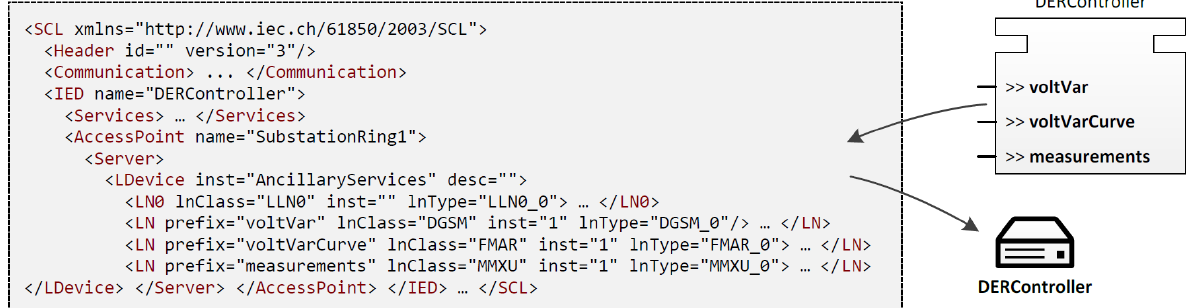
Figure 24. Generated substation configuration description language (SCL) file for configuration of the IEC 61850 server in DER Controller